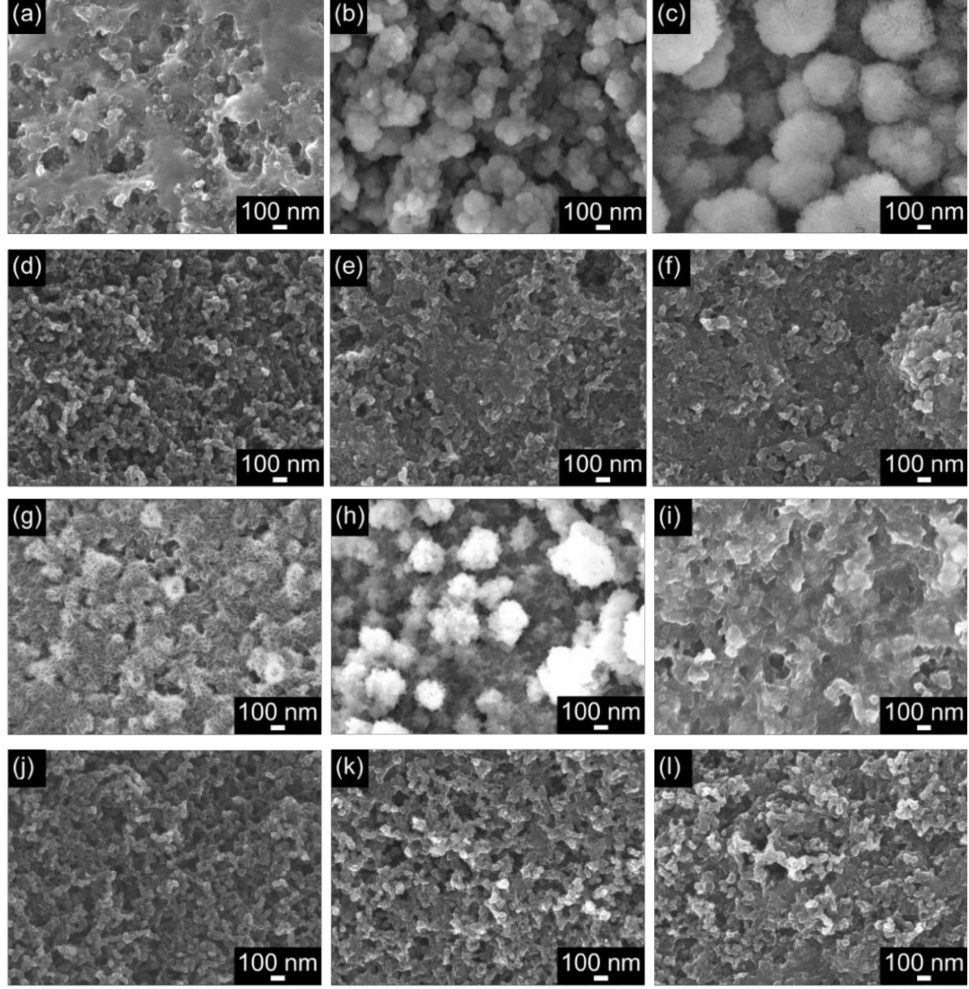
Figure 9. SEM images of ( a – f ) KB and ( g – l ) KB + VUV surfaces after ( a ) 1st discharge, ( b ) 5th discharge, ( c ) 10th discharge, ( d ) 1st charge, ( e ) 5th charge, ( f ) 10th charge, ( g ) 1st discharge, ( h ) 5th discharge, ( i ) 10th discharge, ( j ) 1st charge, ( k ) 5th charge, and ( l ) 10th charge